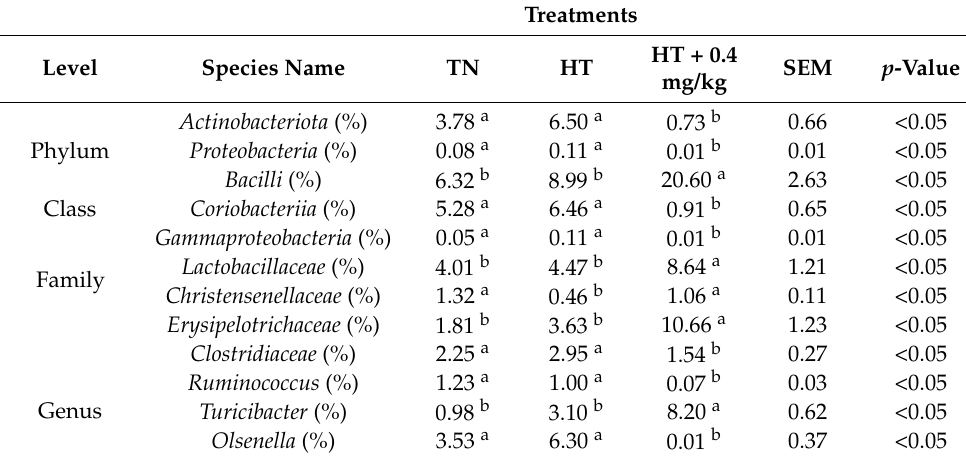
Table 6. Effect of chromium supplementation on cecum digesta microbiota composition under heat stress.